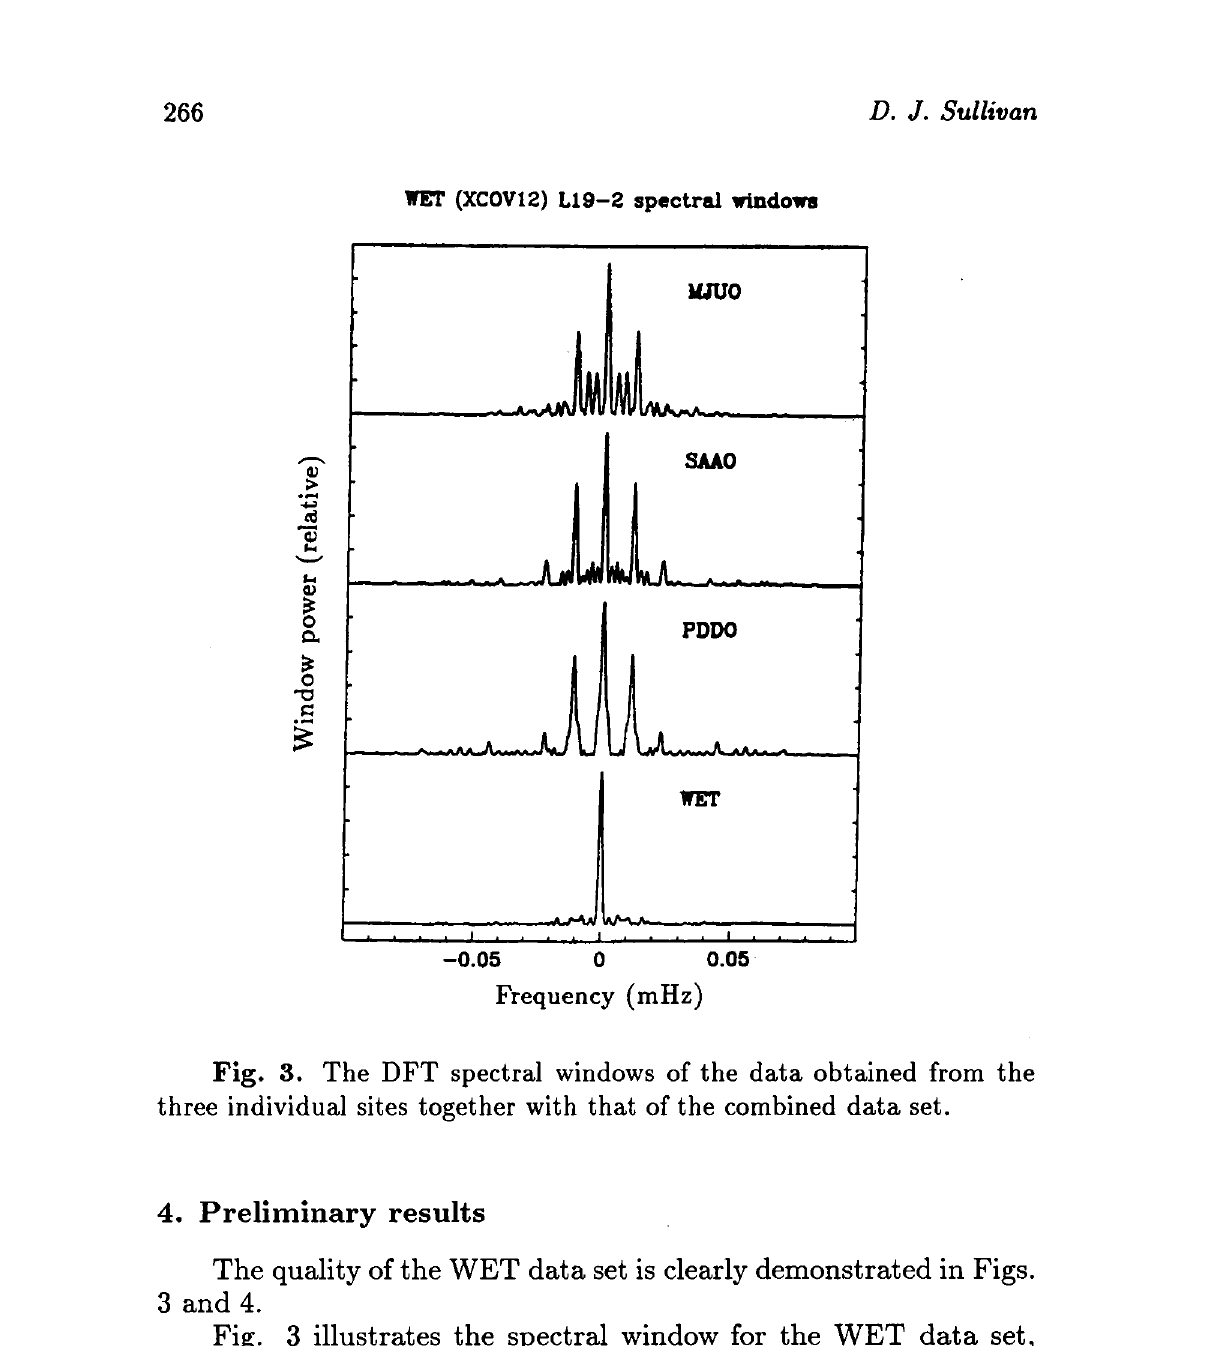
Fig. 3. The DFT spectral windows of the data obtained from the three individual sites together with that of the combined data